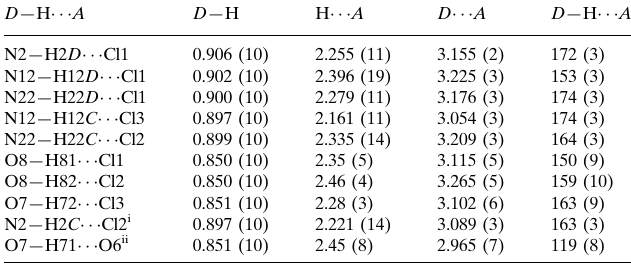
Hydrogen-bond geometry (A˚ , (cid:4) ). D —H (cid:2)(cid:2)(cid:2)